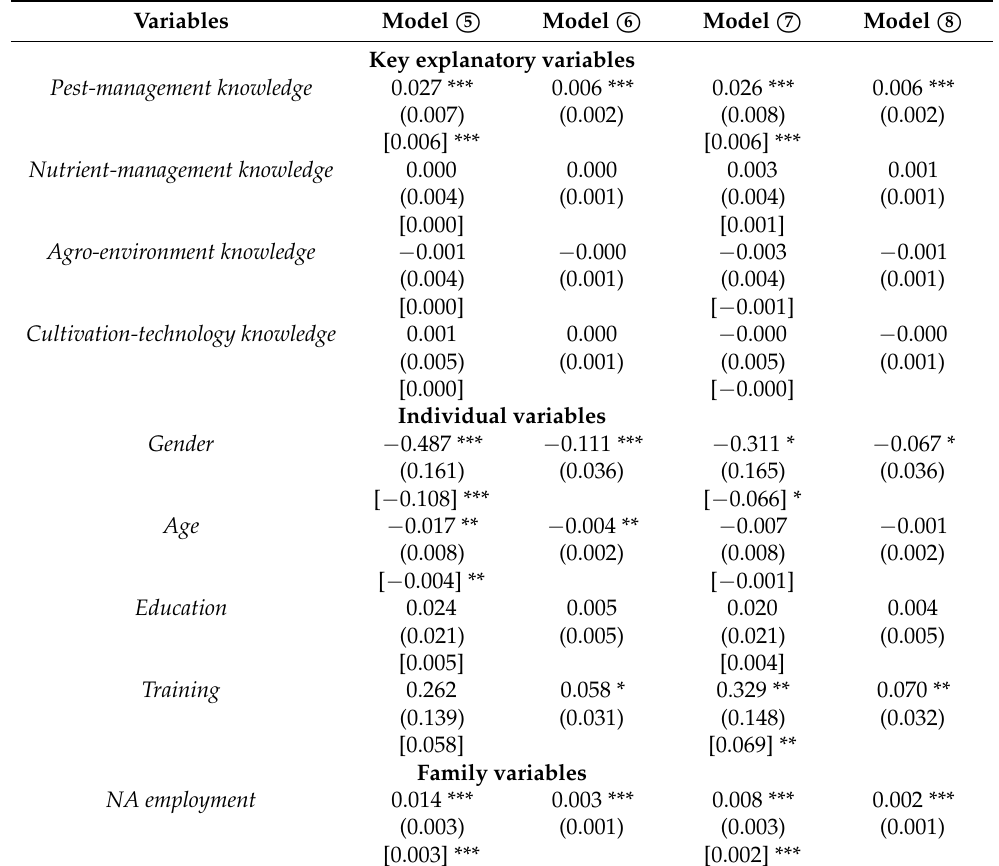
Table 7. Regression estimates of farmers’ IPM adoption intention (specific